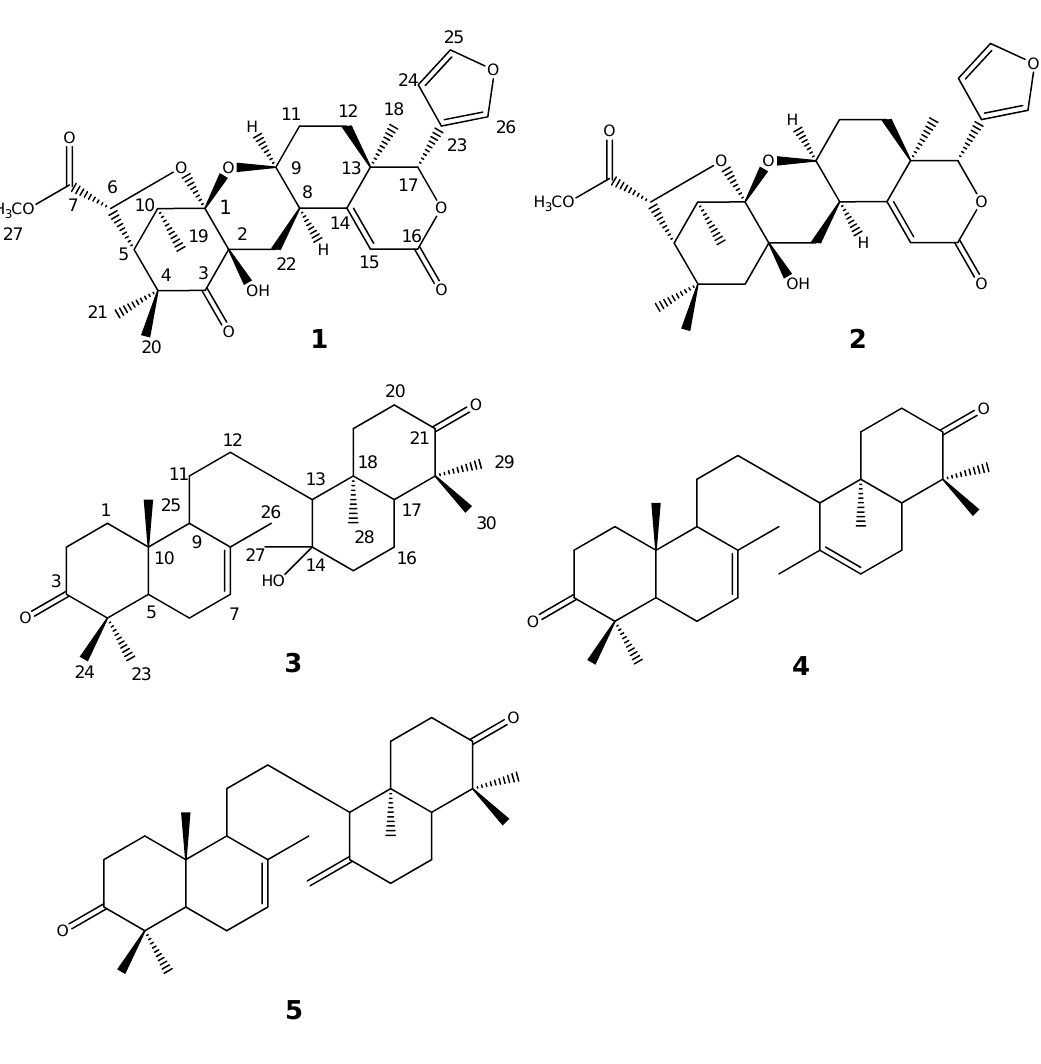
Figure 1. Structure of compounds 1–5